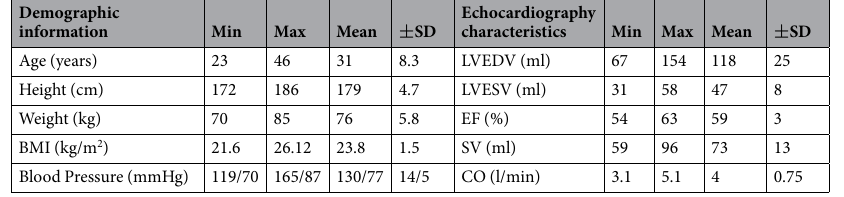
Table 1. Demographic information and descriptive analysis of the echocardiography characteristics. * LVEDV = left ventricular end diastolic volume; LVESV = left ventricular end systolic volume; EF = ejection fraction; SV = stroke volume; CO = cardiac output; BP = blood